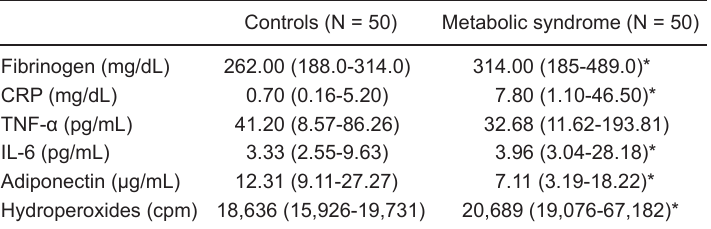
Table 2. Inflammatory markers and lipid hydroperoxide levels of the patients with metabolic syndrome and